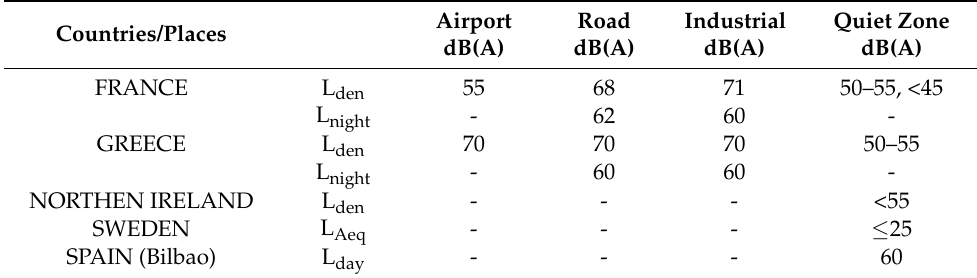
Table 1. Comparison of the regulatory limit values for L den , L night , L Aeq and L day indices for different types of noise sources and Quiet Zone in several European Union (EU) countries covered by the directive EU 2002/49. Airport Countries/Places dB(A)